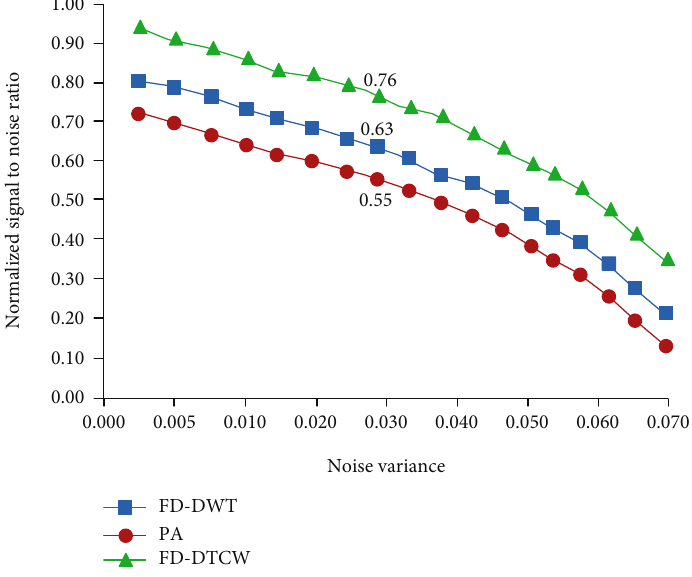
Figure 8: Changes in the signal-to-noise ratio of each model on the test